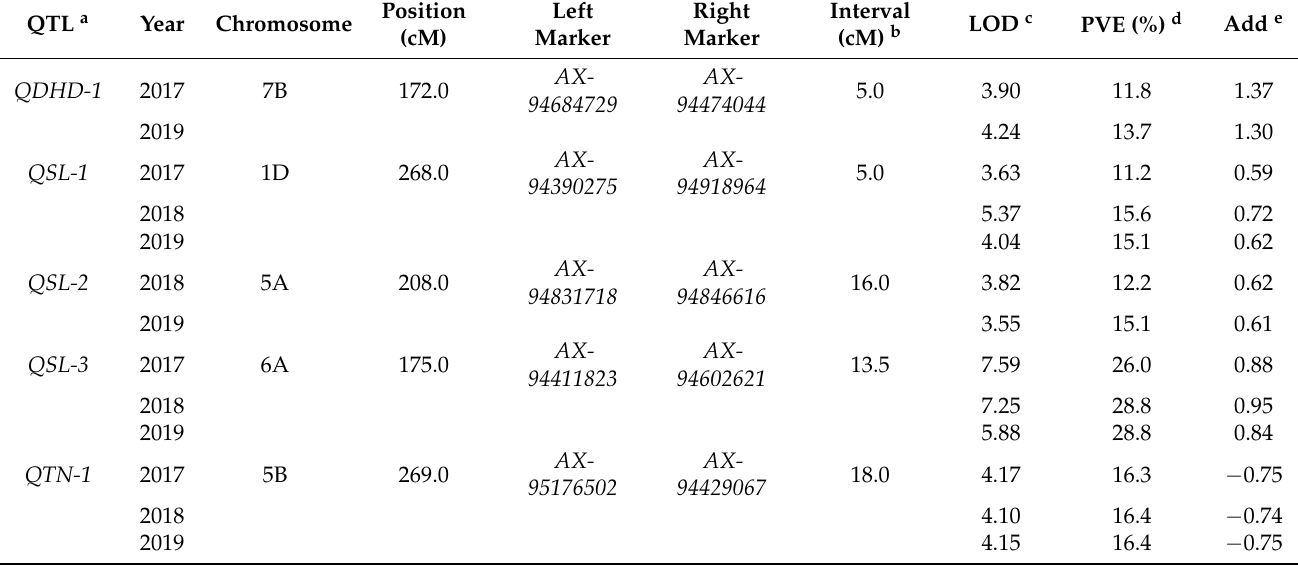
Table 1. Quantitative trait loci (QTLs) for yield potential traits identified from the Taejoong × Keumkang recombinant. inbred